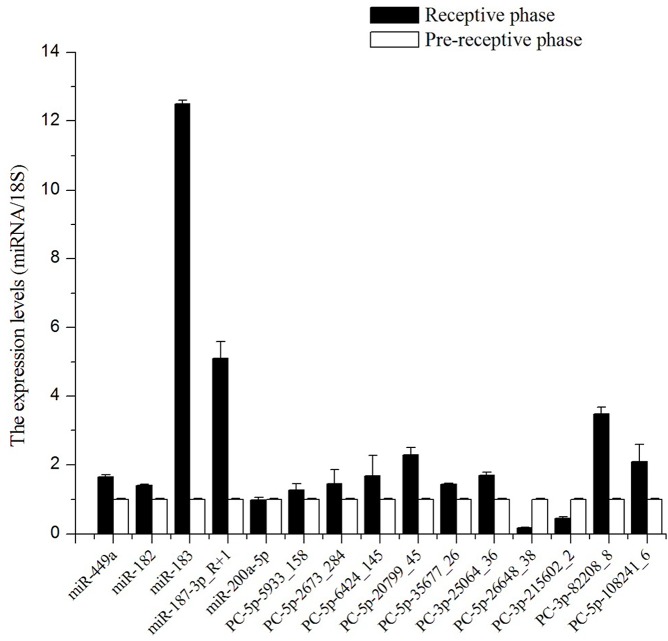
The expression levels of 15 miRNAs were determined by Stem-loop RT-qPCR.Note: 18S was used as internal control gene for normalization in our experiments. Values were “means ± SD” in receptive endometrium (n = 9) that were relative to pre-receptive endometrium (n = 9), whose values all were 1 in this manuscript because of the method of 2-ΔΔCt, ΔΔ Ct = (CT miRNA − CT 18s) R − (CT miRNA − CT 18s) P.